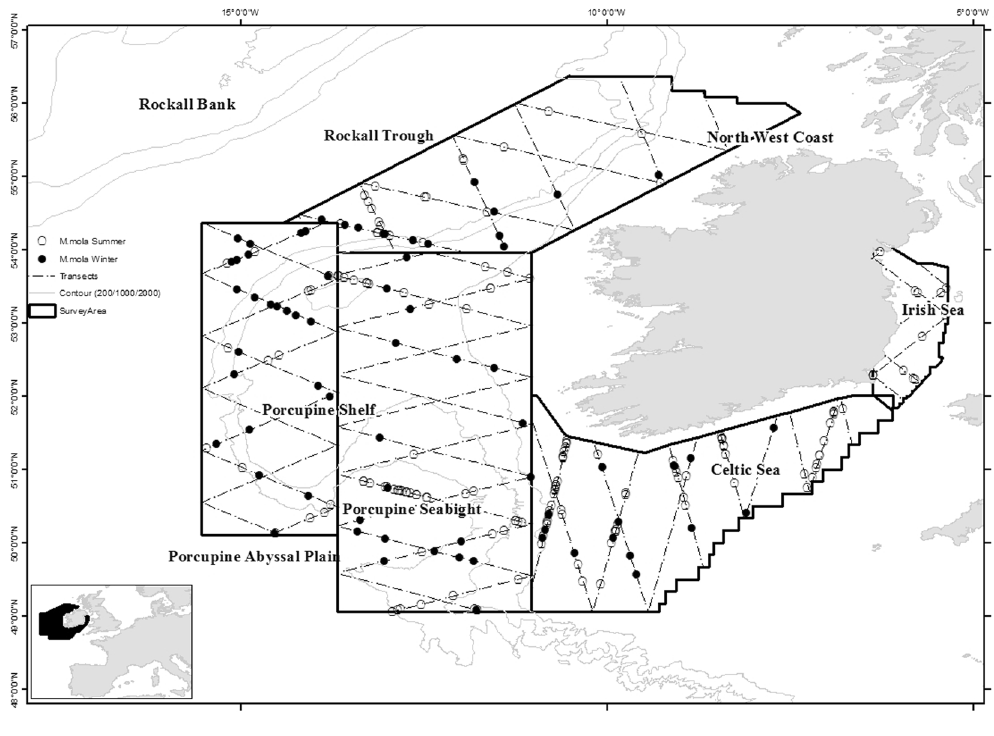
Figure 1. Study area within the northeast Atlantic Ocean showing key areas discussed in the text. Dashed zigzag lines show the transects flown twice within each survey stratum, once per season. Closed dots show winter sightings and open circles show summer sightings. Map generated using ArcGIS 10.2. http://www.esri.com/.